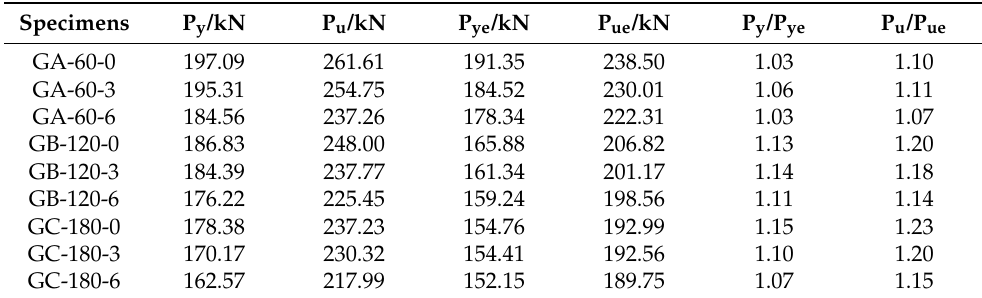
Table 7. Measured value and calculated